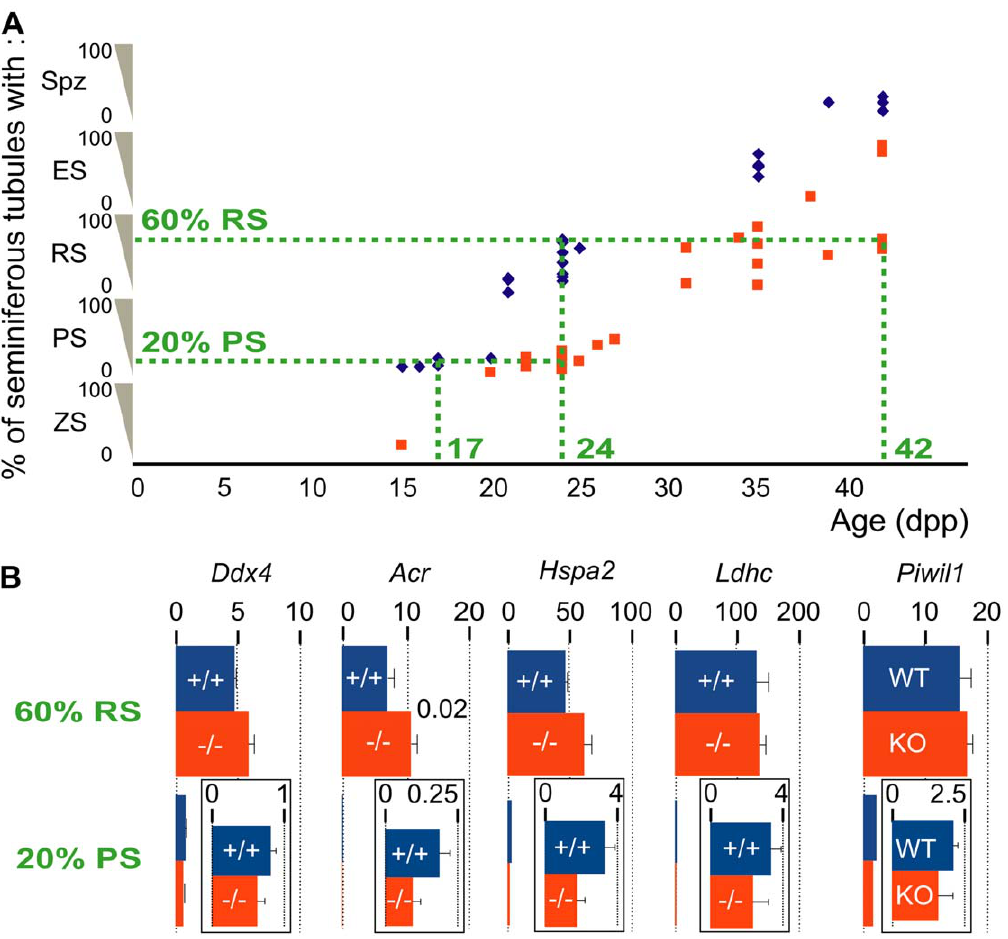
Figure 3. Quantification of the delay of the first wave of spermatogenesis. A , For each mouse, we analysed 300 seminiferous tubules in 15 testis sections. We classified each tubule according to the most differentiated germ cells that it contained (ZS, Zygotene Spermatocyte; PS, Pachytene Spermatocyte; RS, Round Spermatid; ES, Elongated Spermatid; Spz, Spermatozoa). Next, we calculated for each mouse the percentage of seminiferous tubules of each class, and we plotted the percentage of seminiferous tubules of the most advanced class against the age. Blue diamonds and orange squares correspond to individual Celf1 + / + and Celf1 2 / 2 mice respectively. B , We quantified by real-time RT-PCR the relative amounts of the indicated mRNAs (Mouse Vasa Homolog, Ddx4 ; Proacrosine, Acr ; Heat Shock Protein 70.2, Hspa2 ; Lactate Dehydrogenase 3, Ldhc ; Miwi, Piwil1 ) for + / + and 2 / 2 testes of similar stages of spermatogenesis but different ages: lower panels and inserts, 17 dpp + / + (blue bars) and 24 dpp 2 / 2 (orange bars) testes with 20% of seminiferous tubules of the PS class; upper panels, 24 dpp + / + (blue bars) and 42 dpp 2 / 2 (orange bars) testes with 60% of seminiferous tubules of the RS class. Results are expressed as the means of 3–5 animals for each genotype. Error bars are standard deviations. We used a Student’s t-test to statistically compare the + / + and the 2 / 2 genotypes, and the p-values below 0.1 are given on the right of the corresponding bars.